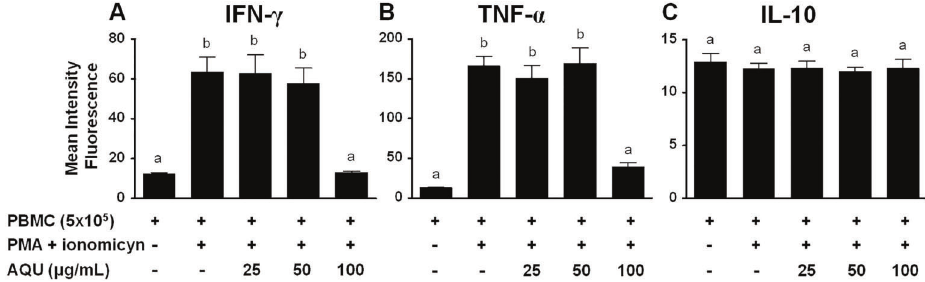
Figure 3. Effect of P. brasiliensis aqueous extract on cytokine production by lymphocytes. Peripheral blood mononuclear cells (PBMCs, 5 (cid:2) 10 5 cells; n=8) were stimulated with phorbol myristate acetate (PMA) in the presence of 25, 50, or 100 m g/mL of P. brasiliensis aqueous extract (AQU). Non-stimulated cultures constituted the negative control (PBMC), and cultures stimulated with PMA + ionomycin in the absence of plant extract constituted the positive control. Production of IFN- g ( A ), TNF- a ( B ), and IL-10 ( C ) was determined by fl ow cytometry. Results are reported as means ± SD. Different letters indicate signi fi cant differences (P p 0.05, ANOVA with Tukey post hoc ).